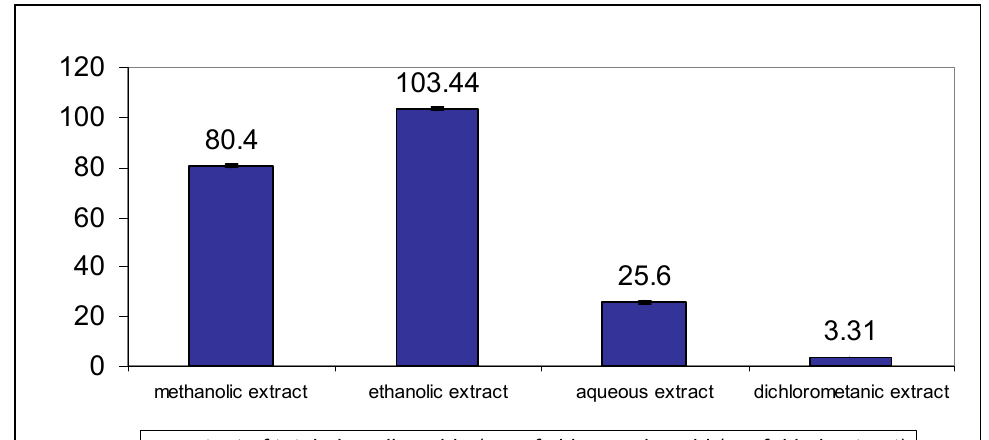
Figure 4. Contents of total phenolic acids expressed as milligrams of chlorogenic acid per gram of dried extract in different C. platycarpos extracts. Each value is the mean ± standard deviation of six independent measurements.